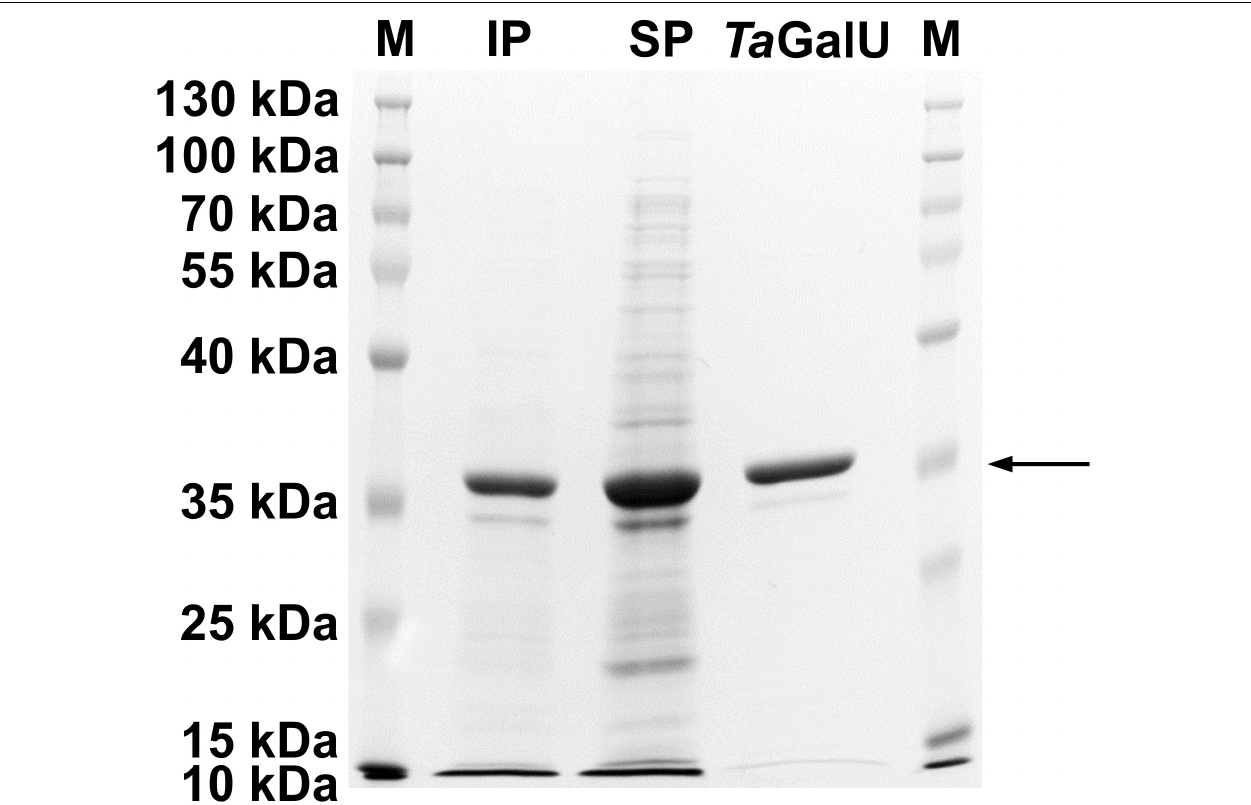
FIGURE 1 | SDS-PAGE gel of Ta GalU after purification. The arrow indicates the expected molecular weight of 33.7 kDa. M, protein marker (Thermo Scientific TM PageRuler TM Prestained Protein Ladder); IP, insoluble protein fraction; SP, soluble protein